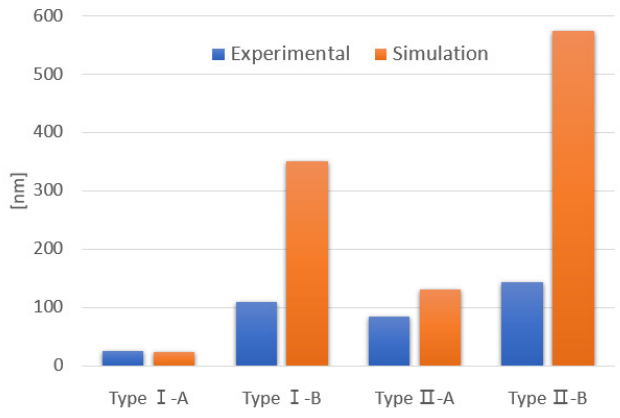
Figure 13. Change in die warpage due to temperature change from 25 °C to 85 °C .